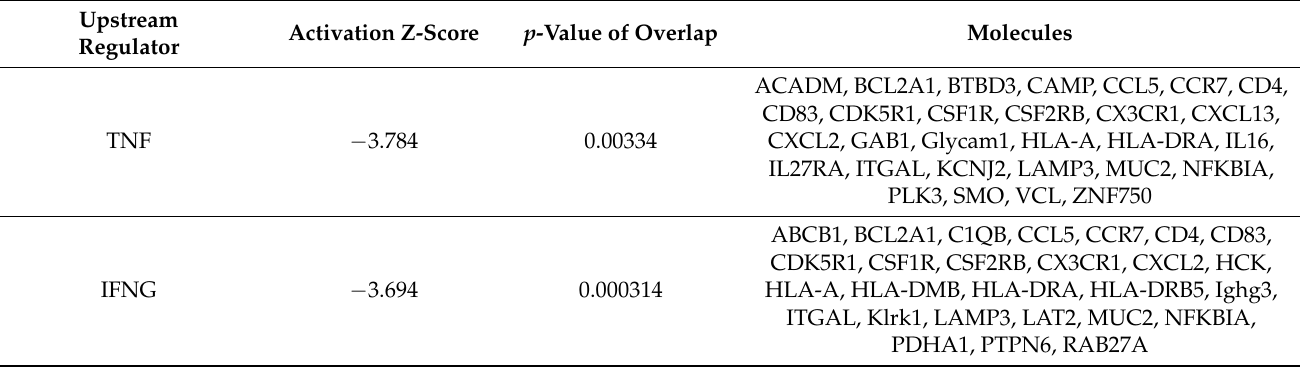
Table 2. Upstream regulators identified from protection with GM–SELP in RIP